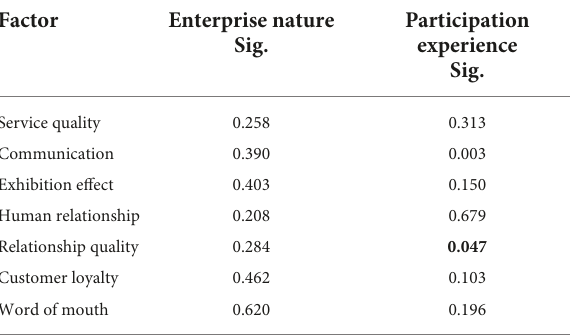
TABLE 8 One way analysis of variance analysis. Factor Enterprise nature Sig.